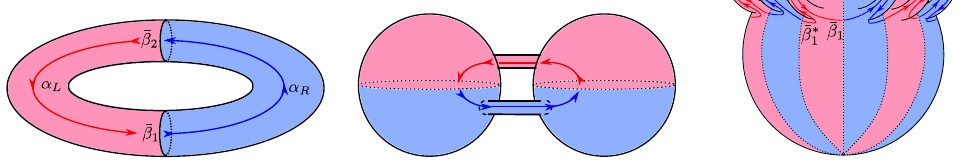
Figure 14 . (Left) The state on the torus and (middle) the same state redrawn suggestively. (Right) The three-manifold of the replica path